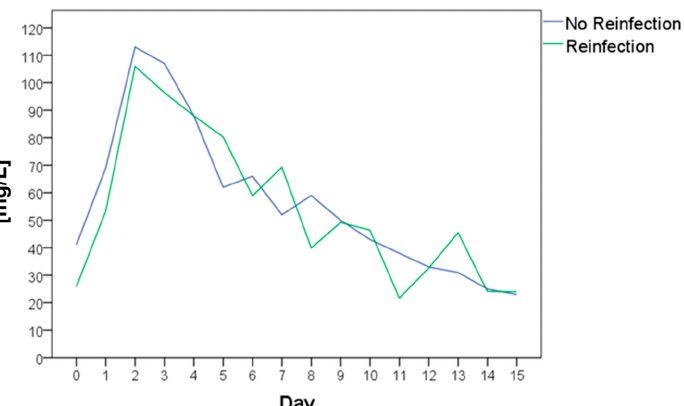
Figure 6. The area under the curve (AUC) of the mean C-reactive protein (CRP) values preopera- tively and in the further clinical course of cases without reinfection (( a ) green curve) and with rein- fection (( b ) orange curve). 4. Discussion Septic two-stage revision surgery is a standard treatment for a PJI of a THA with success rates of up to 90–100% [6–10]. It is, however, extremely important to filter out subsequent ther- apy failures at an early stage in order to be able to adapt the therapy. This requires parameters that guide the decision as to whether an infection is controlled or not. A lot of studies are available on the diagnostic workup prior to septic revision surgery, leading to standardized preoperative decision making according to the MSIS and ICM criteria [17,18]. However, there is an absence of such a standardized preoperative diagnostic workup to guide the timing of stage-two surgery and the decision as to whether a PJI is controlled or not. Those studies avail- able for the diagnostic workup prior to stage two mainly report on TKA or mixed collectives with only one single study for a THA collective [11–14,16]. Because we believe that joint-spe- cific diagnostic and therapeutic algorithms are necessary, there is a need for studies investi- gating this subject exclusively for THA. We, therefore, conducted a study regarding the CRP and WBC count. These param- eters are part of the routinely obtained preoperative laboratory sample and are still used to evaluate infections by many surgeons.